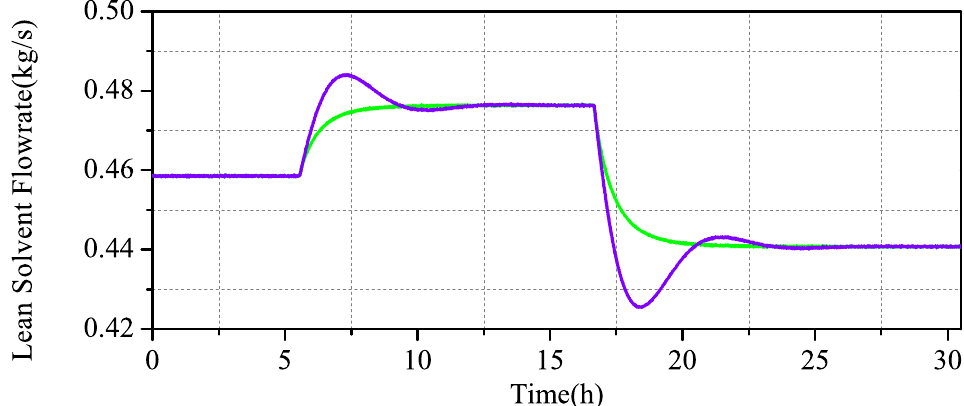
Figure 11. Scenario 1: Comparison of MPC and PID simulation of the CO 2 capture